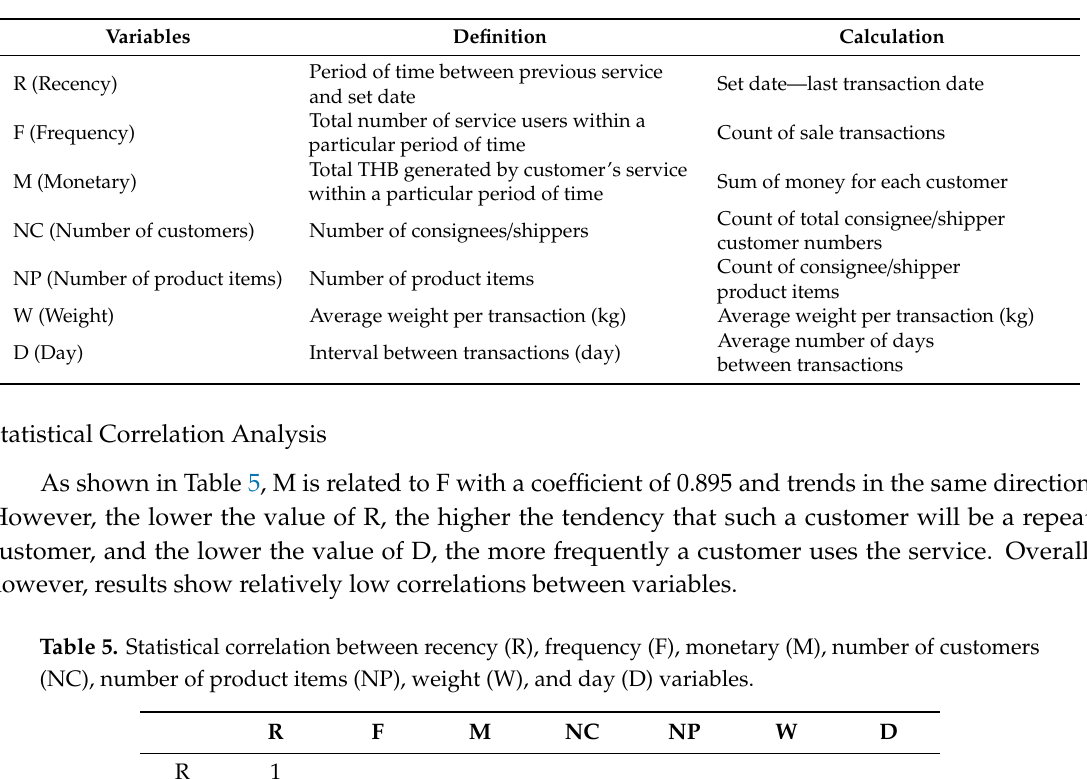
Table 4. Definition of R, F, M, NC, NP, W, and D variables.